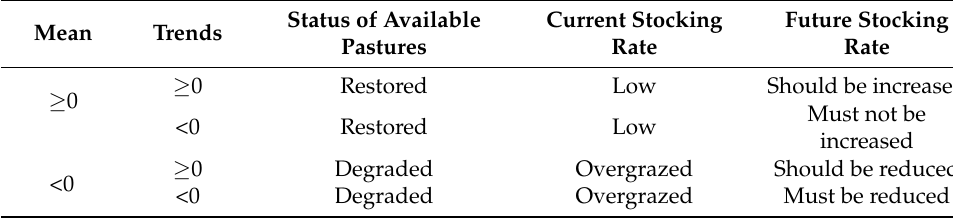
Table 1. The direction and amplitude of NPP gap